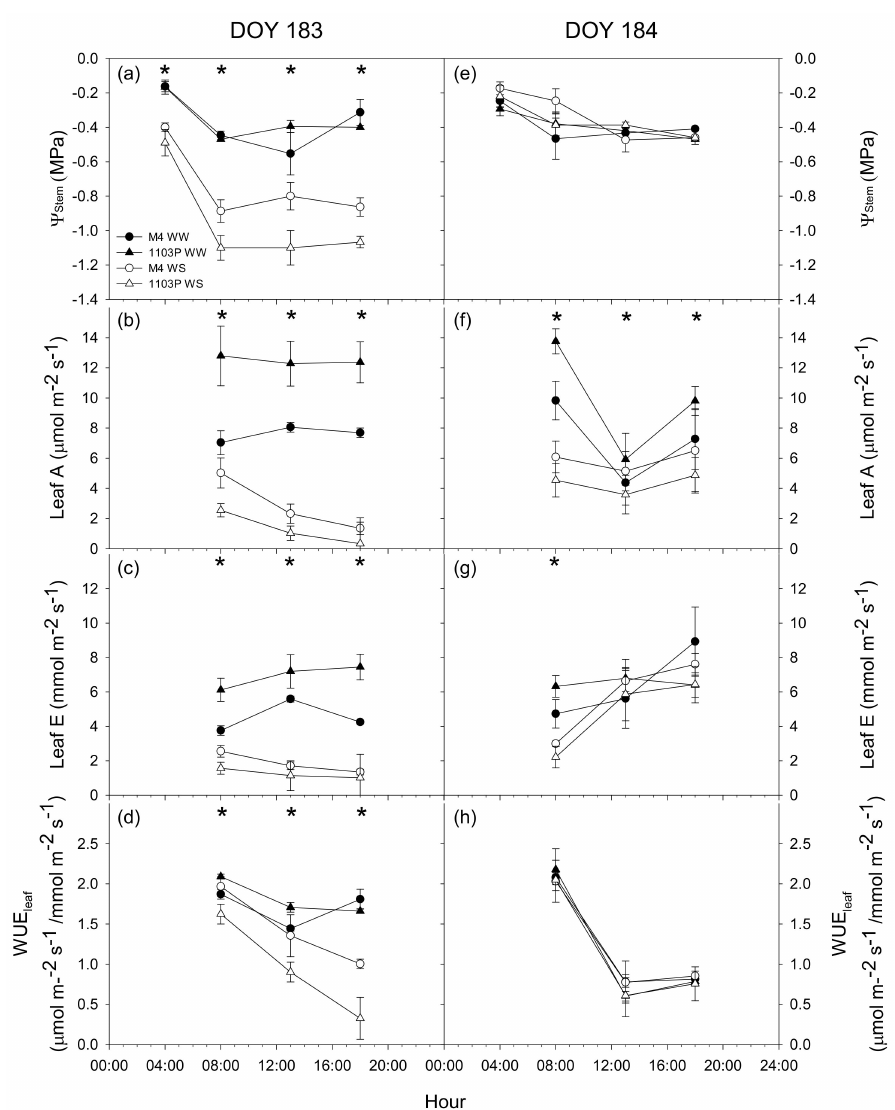
Figure 3. Trends for stem water potential ( Ψ stem , panels a , e ), leaf assimilation (A, panels b , f ), leaf transpiration (E, panels c , g ), and water use e ffi ciency (WUE leaf , panels d , h ) of vines cv. Grechetto Gentile grafted to M4 and 1103 Paulsen on the days of the year (DOY) 183 (panels a – d ) and 184 (panels e – h ). M4-WW = well-watered vines grafted to M4; 1103P-WW = well-watered vines grafted to 1103 Paulsen; M4-WS = water-stressed vines grafted to M4; 1103P-WS = water-stressed vines grafted to 1103 Paulsen; DOY = day of the year. Bars represent standard errors ( n = 3). Asterisks indicate dates within which significant di ff erences among treatments were found, according to the SNK test ( p <